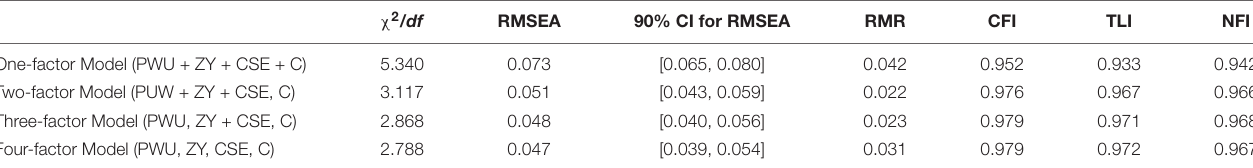
TABLE 4 | Confirmatory factor analysis (CFA).